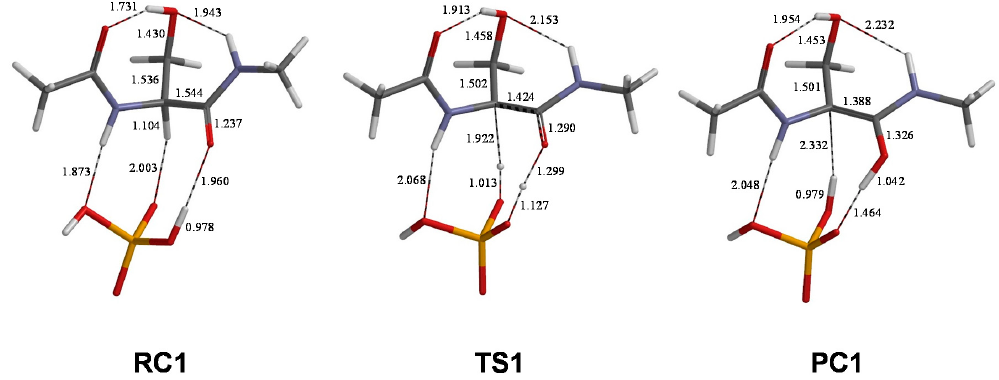
Figure 3. Energy diagrams of the three enolization pathways (pathway 1, pathway 2, and pathway 3) for the model compound. RC: reactant complex; TS: transition state; PC: product complex. The relative